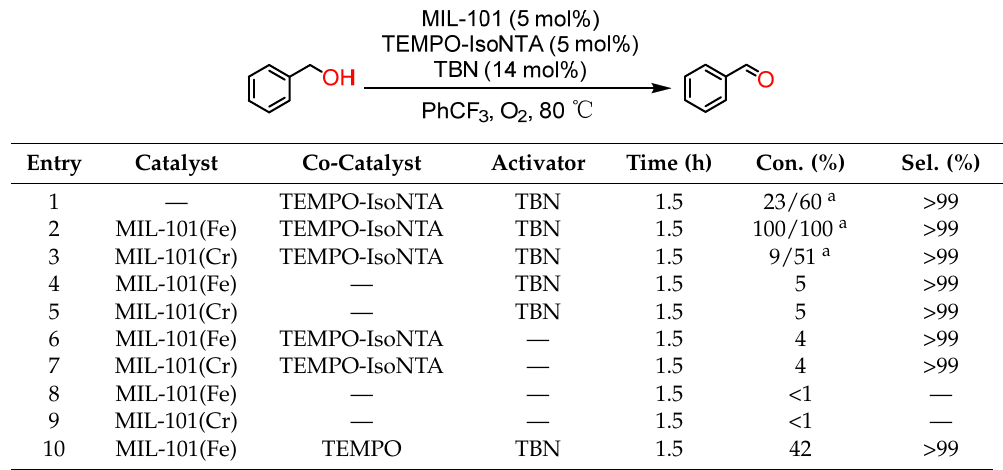
Table 1. Aerobic oxidation of benzyl alcohol under various conditions.